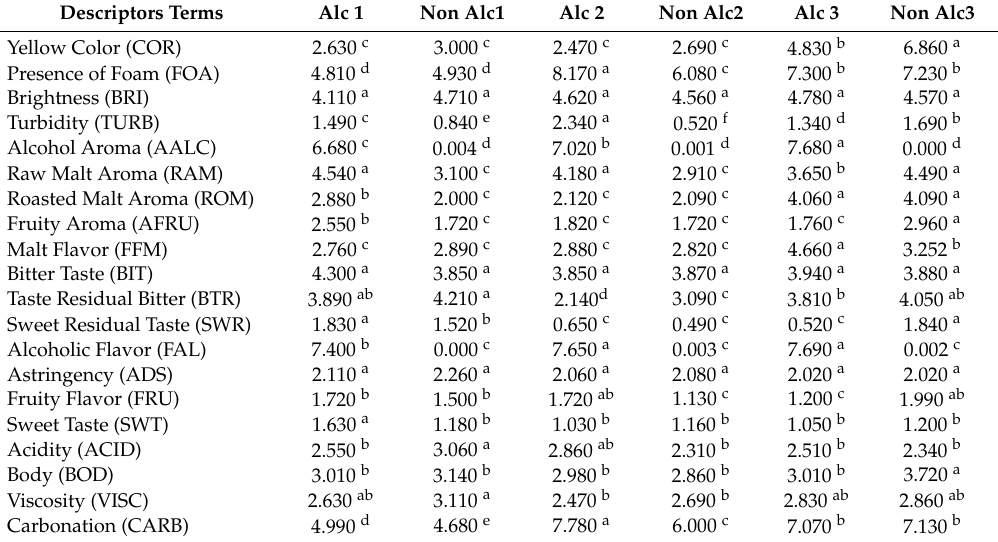
Table 2. Averages * of the descriptor terms of traditional Pilsen beers samples (alcoholic and non-alcoholic) found using the quantitative descriptive analysis (QDA ®